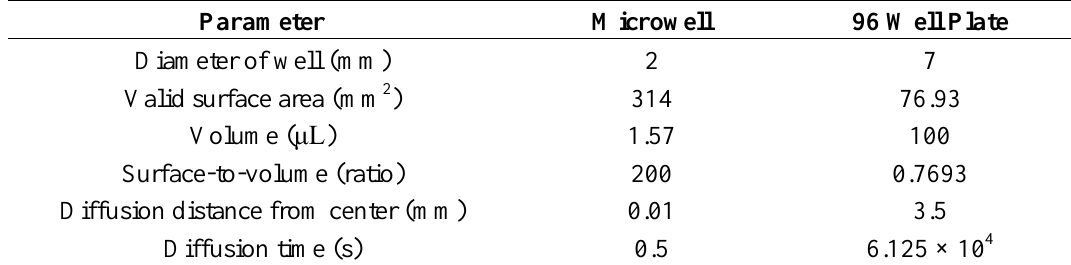
Table 1. The physical parameters of microwell array and 96-well